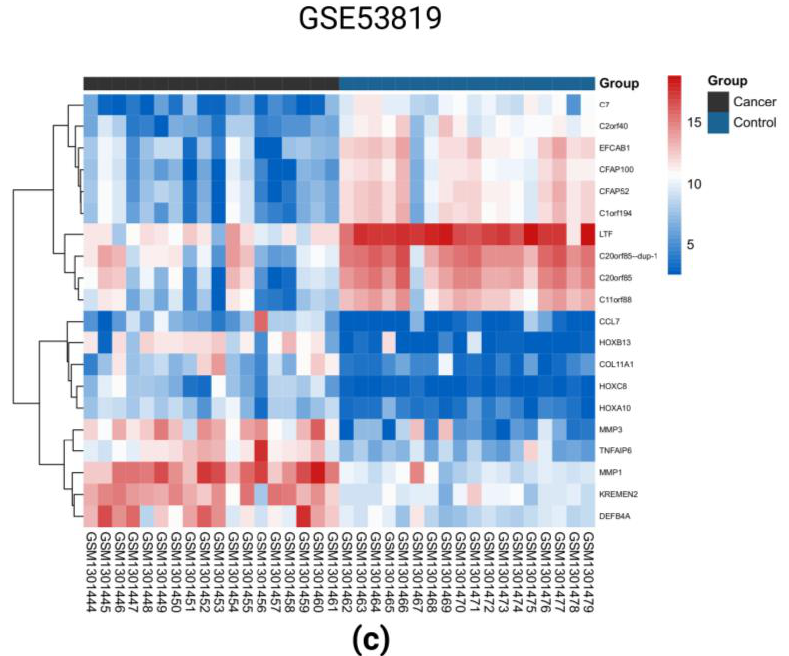
Figure 2. Heat maps of the top 20 DEGs in GSE40290 ( a ), GSE61218 ( b ), and GSE53819 ( c ).